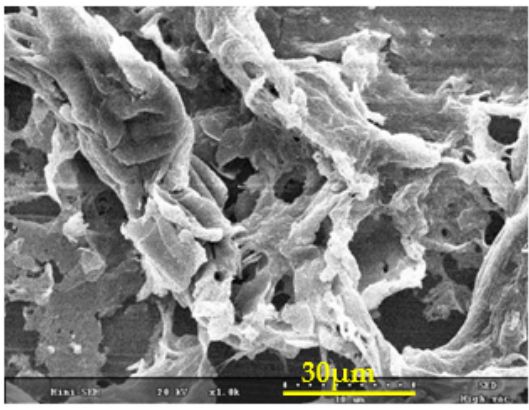
Figure 6. SEM image of AC (Db-s) showing a porous